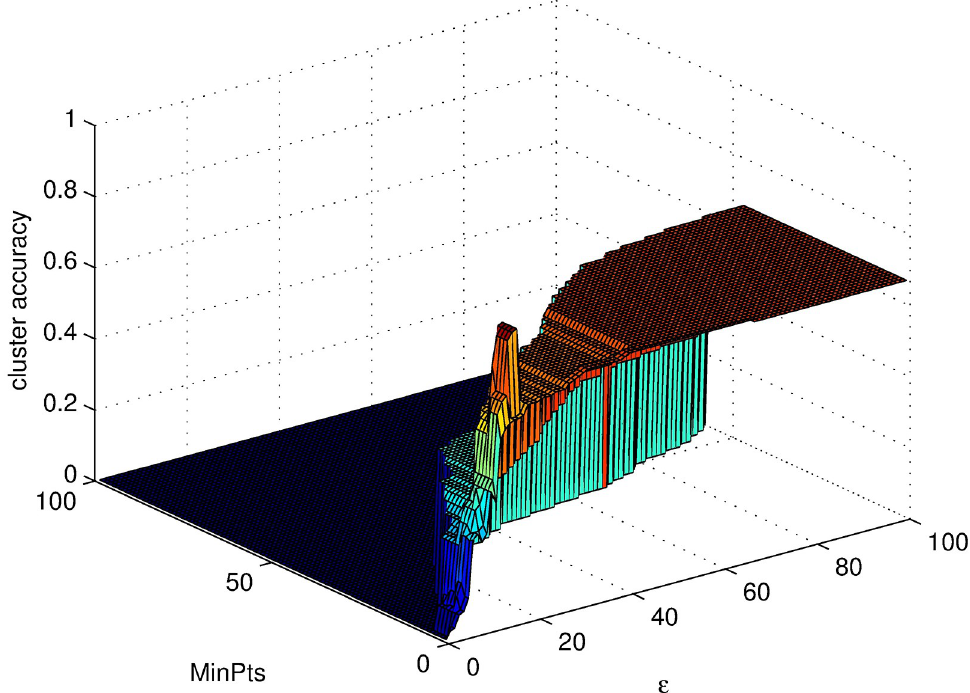
Fig 6. The cluster accuracy of different parameter values in the Iris database obtained by DBSCAN-CPPI.